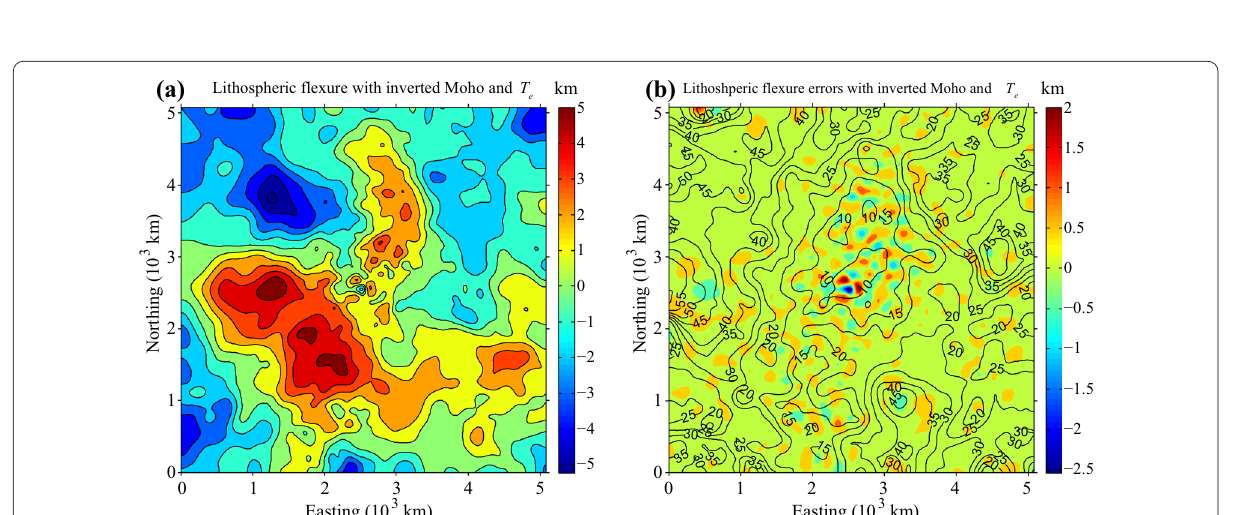
Fig. 12 a Lithospheric flexure using the inverted Moho and T e values. b Base map is the lithospheric flexure errors from the model inversion using the inverted Moho and T e values, the contours are from T e